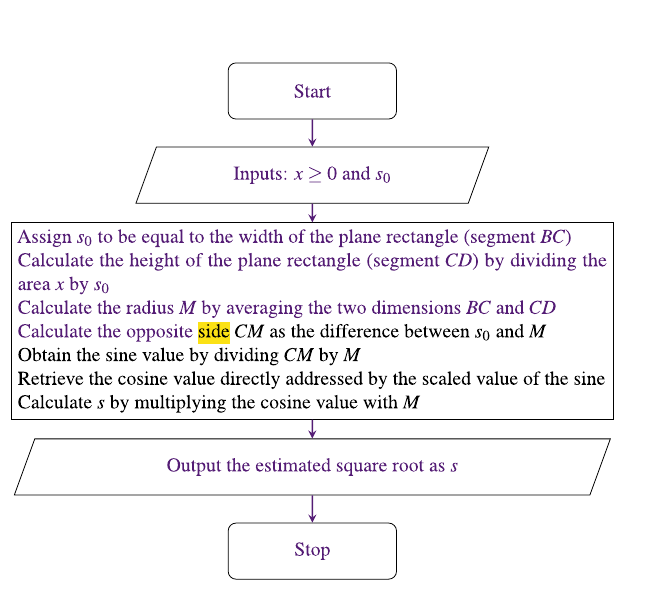
Table 2. The impact of the step size of sin θ on the size of the lookup table and its utilization, assuming a 16-bit precision of cos θ values.